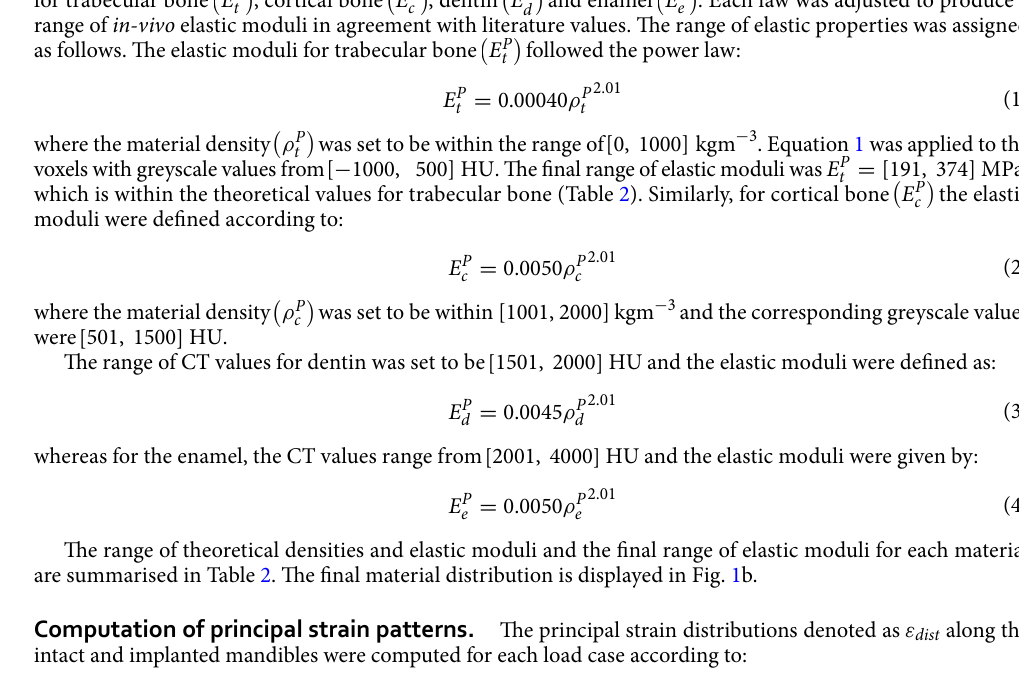
. The differences between